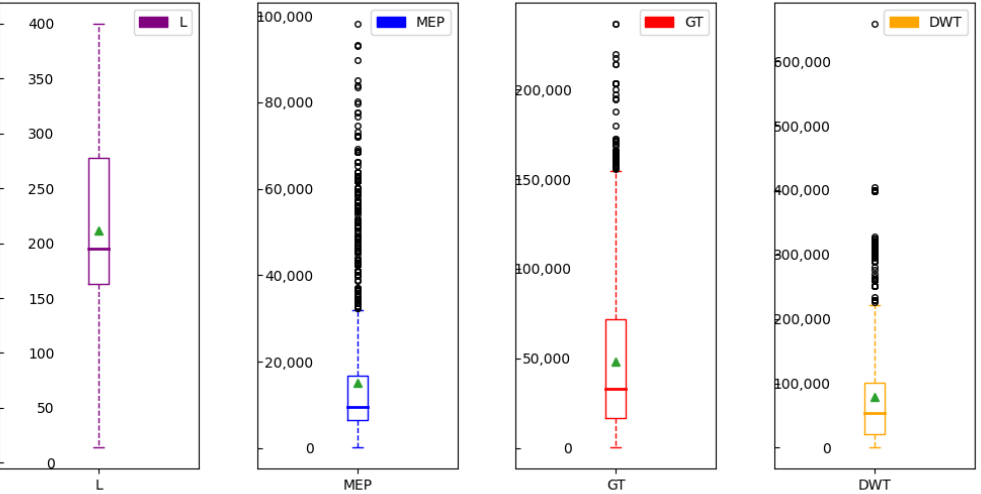
Figure 4. Box plots of descriptive statistics for raw data: L, MEP, GT, and DWT. The green triangle represents the mean value, and the hollow circles represent the outliers.